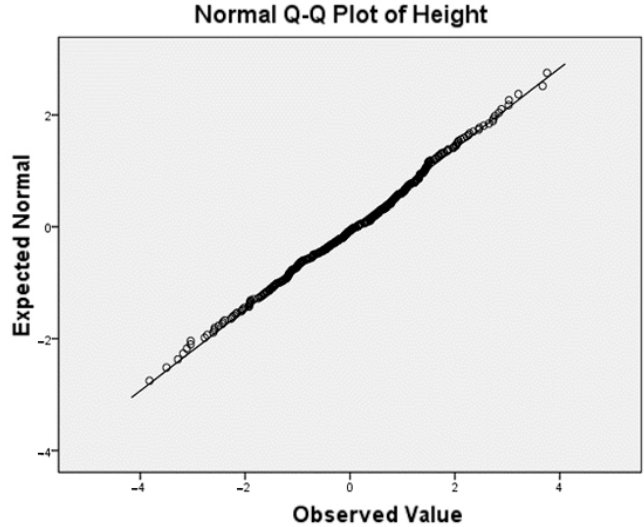
Figure 1. Normal probability Q–Q plot.